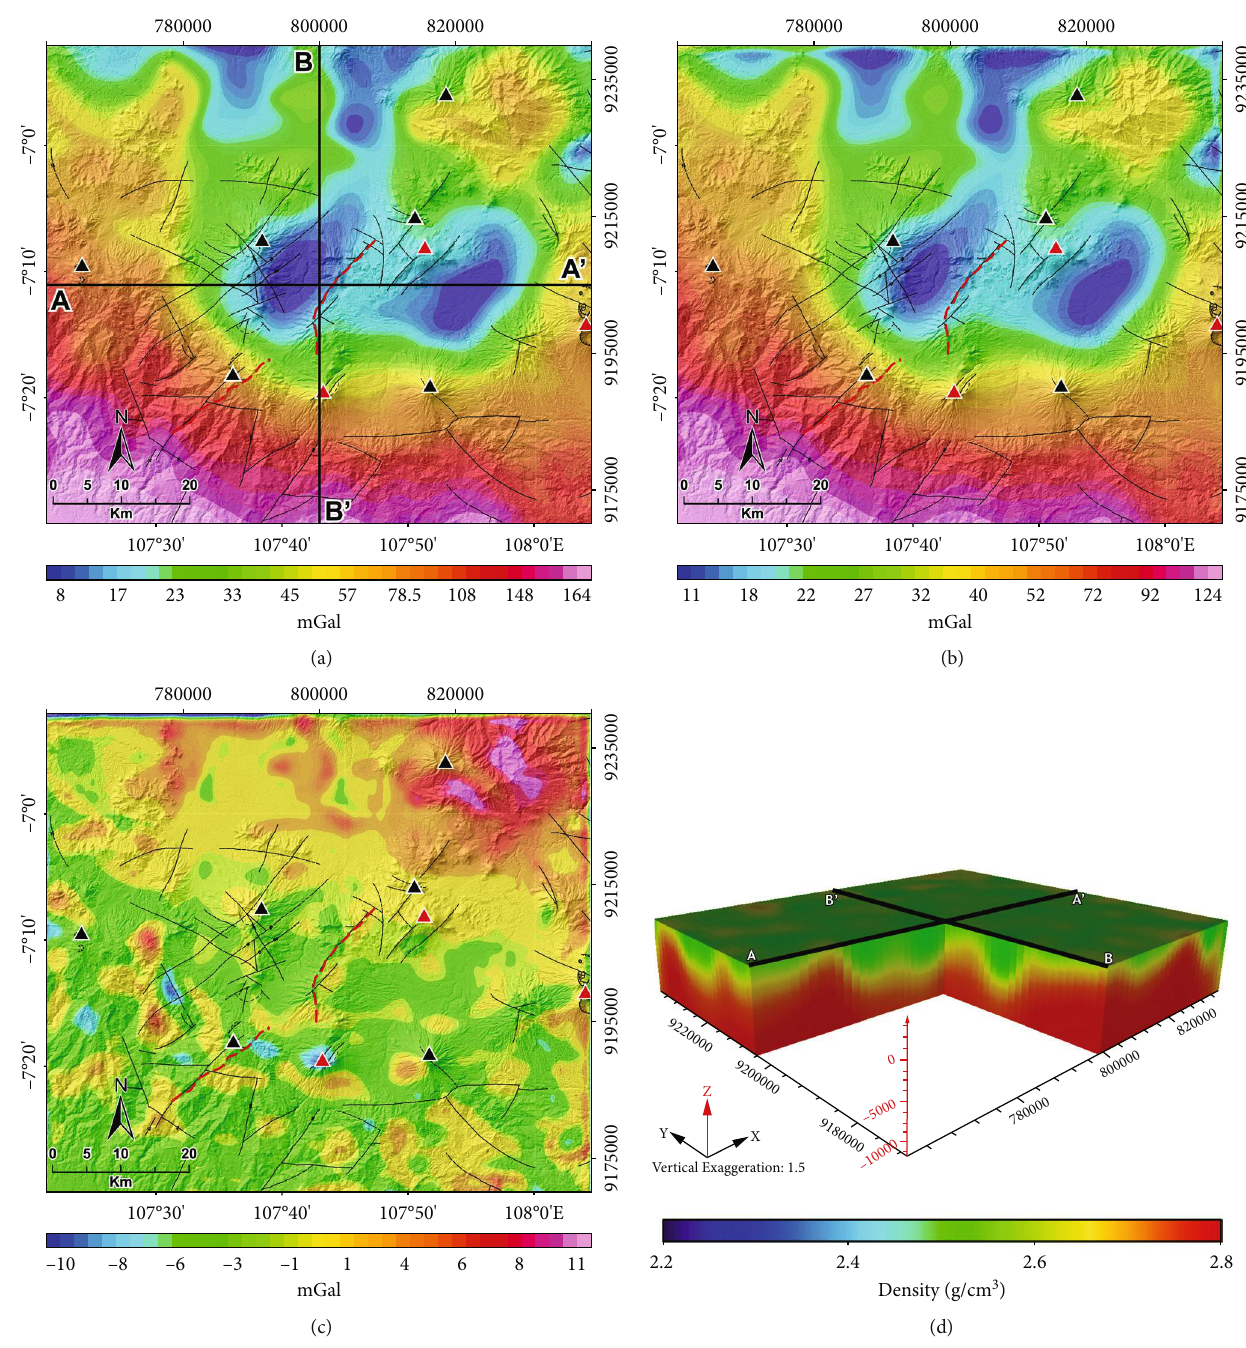
Figure 8: The results of 3D gravity inversion modeling, measured data (a), calculated data or inverse model response (b), mis fi t (c), and density block model sliced at A-A ′ and B-B ′ cross-sections